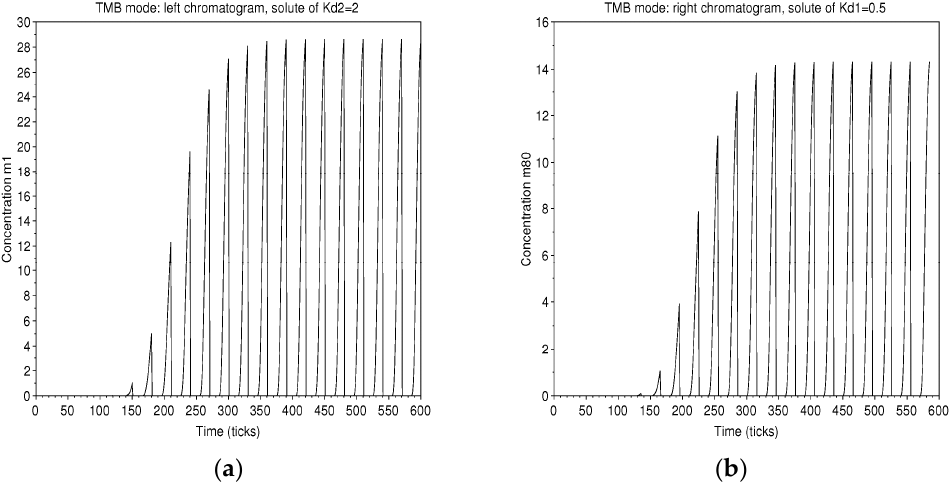
Figure 15. TMB mode: chromatograms of the solute of K d 2 = 2 in solvent 2, on the left ( a ), and of the solute of K d 1 = 0.5 in solvent 1, on the right ( b ). The initiation of the process and the established regime are identified. Collections can be made every 15